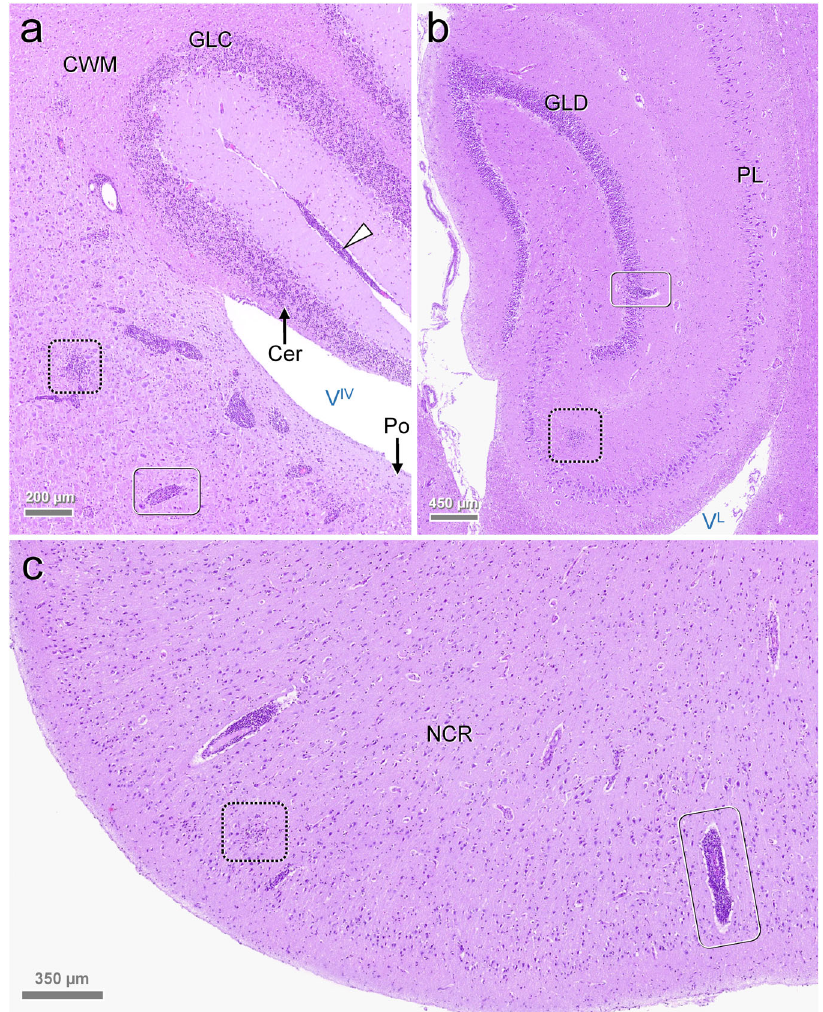
Fig. 4 | Encephalitic pattern in rustrela virus (RusV)-infected cats. Histology typically features polio-predominant, perivascular lymphohistiocytic cuffs ( a – c : solid boxes) and angiocentric in fi ltrates ( a – c : dashed boxes). They are most pro- minent in brain stem ( a : Po), hippocampus formation ( b ) and neocortex ( c ). Lep- tomeningeal in fi ltrates ( a : white arrowhead) also occur in areas with sparse parenchymalin fi ltration suchas the cerebellum ( a : Cer). Stain: haematoxylin